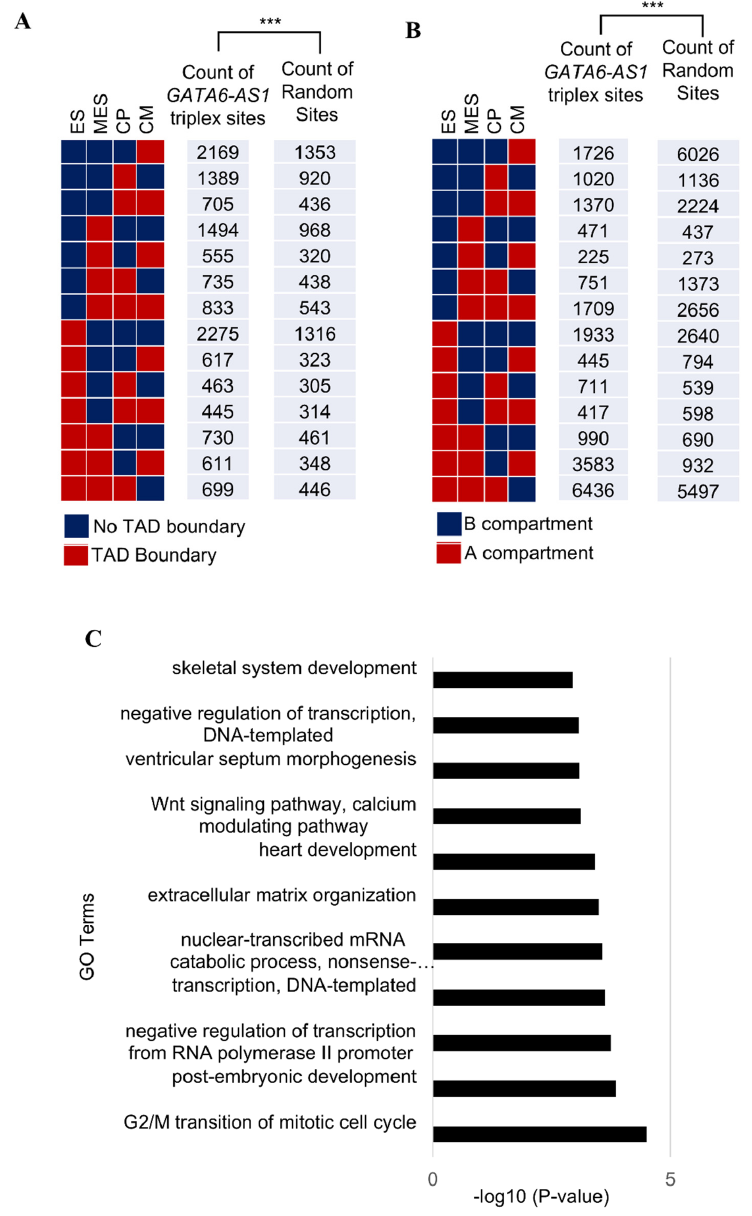
Figure 2. GATA6-AS1 and dynamic loss/gain of TAD boundaries and A/B compartment switching. ( A ) Fourteen unique possibilities of a genomic site based on whether it was associated with the gain or loss of a TAD boundary during cardiac differentiation stages (ES, MES, CP, and CM). The counts for GATA6 - AS1 and the control set of randomized sites annotated as one of these unique possibili- ties are shown and were compared using the Chi-Square test. p -value < 0.001 is indicated by ***. ( B ) As in panel ( A ), 14 unique possibilities of a genomic site based on whether it was associated with switching between the two types of compartments, A and B, during the cardiac differentiation stages (ES, MES, CP, and CM). The counts for GATA6 - AS1 and the control set of randomized sites